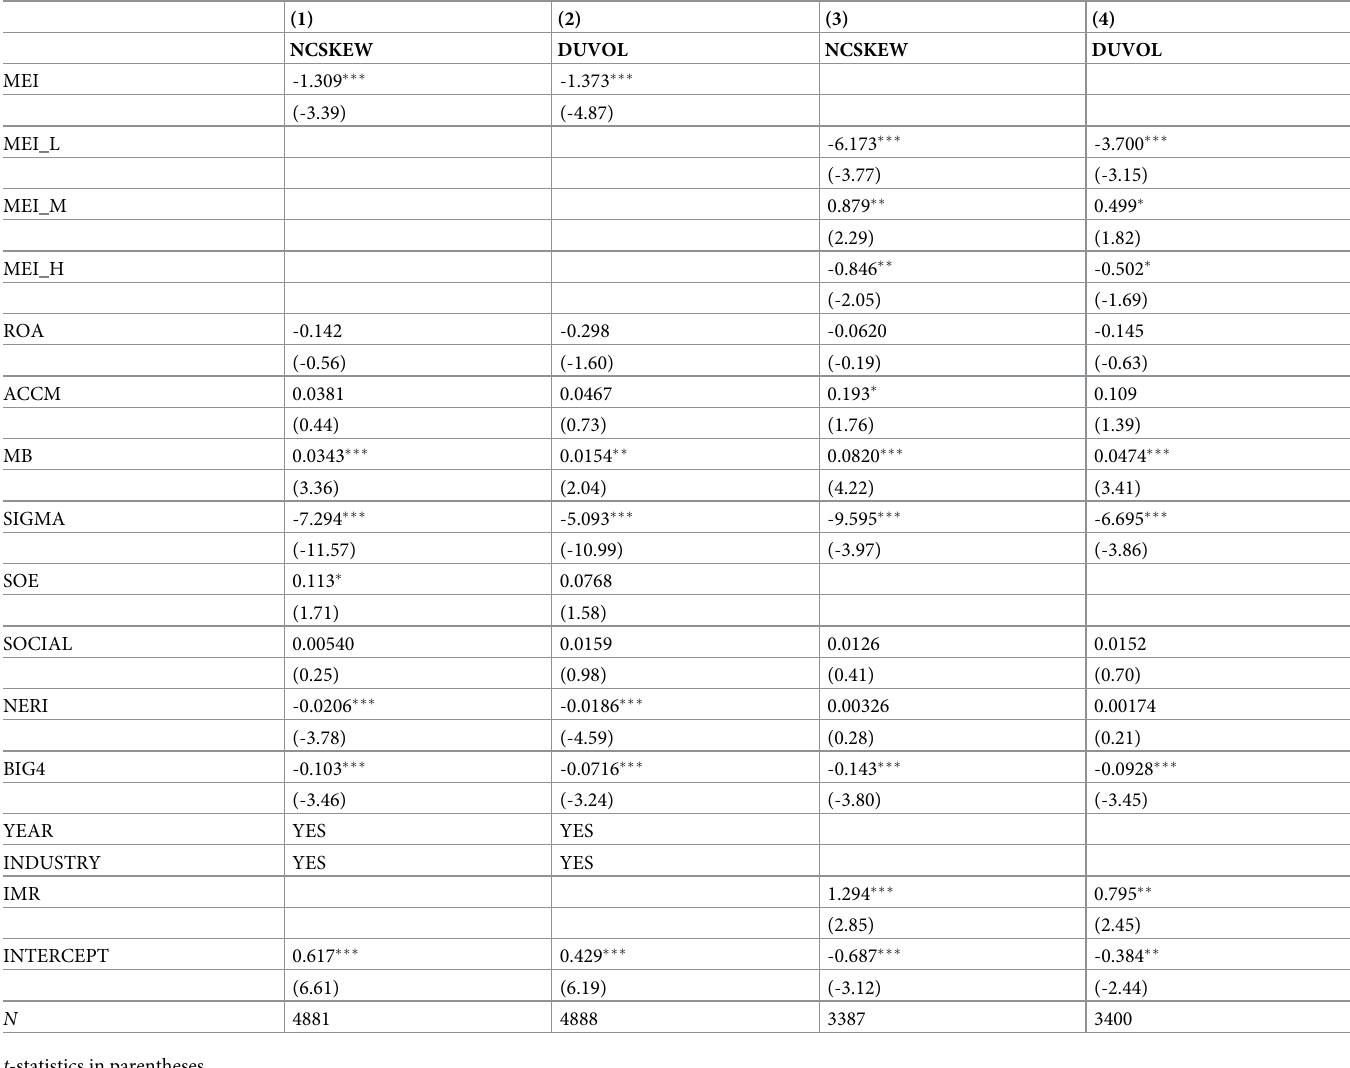
Table 5. Robustness tests: Two-stage least squares (2SLS) model and Heckman two-stage